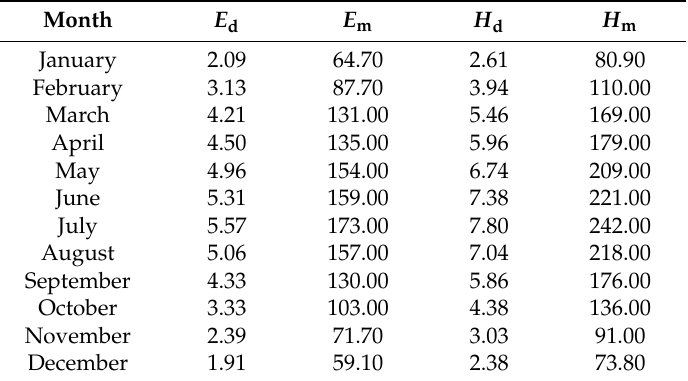
Table 1. Irradiance at zone III in Spain